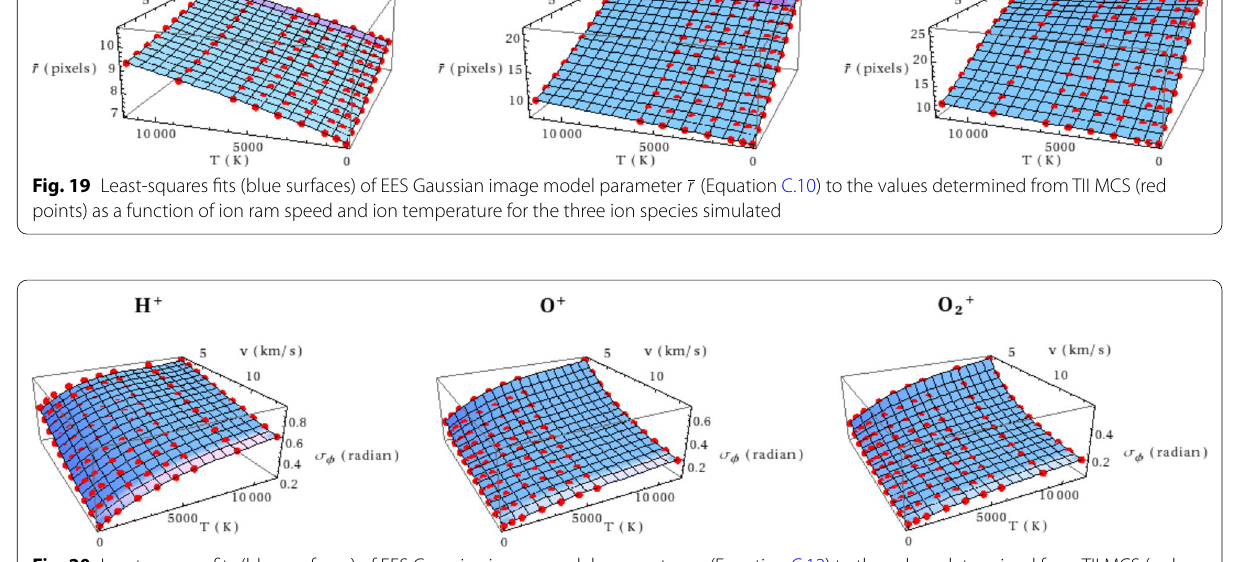
Fig. 20 Least-squares fits (blue surfaces) of EES Gaussian image model parameter σ φ (Equation C.12) to the values determined from TII MCS (red points) as a function of ion ram speed and ion temperature for the three ion species simulated